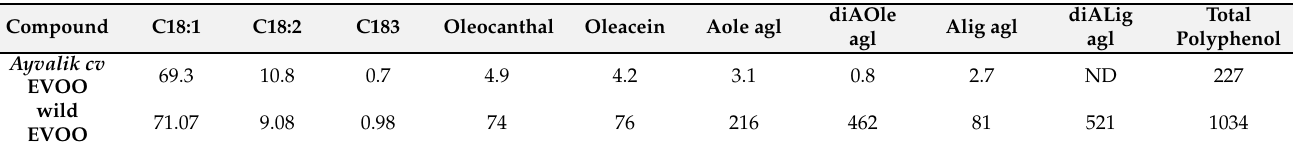
Table 1. Mean values of the major quantified fatty acids in (%), phenolic compounds (mg/kg). Values for Ayvalik cv EVOO represent the mean value of three replicate analyses data from [4,5]. Values for Olea europaea ssp. europaea var. sylvestris EVOO from the GC-FID HPLC-UV, and NMR represent the average of two replicates analysis. Abbreviations: ND not detected, diAOle agl dialdehyde form of oleuropein aglycone, AOle agl aldehydic form of oleuropein aglycone, Alig agl aldehydic form of ligstroside aglycon.